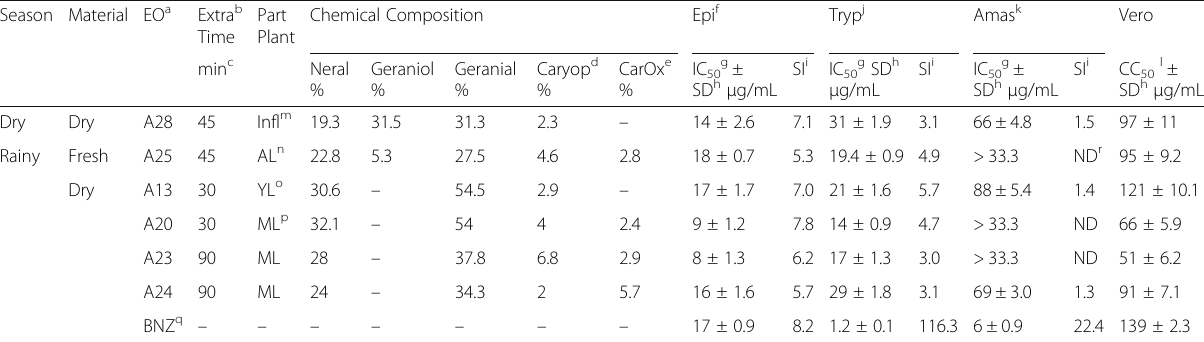
Table 3 Relative chemical composition and anti-proliferative effect on T. cruzi of EOs extracted from the Citral chemotype of L. alba Season Material EO a